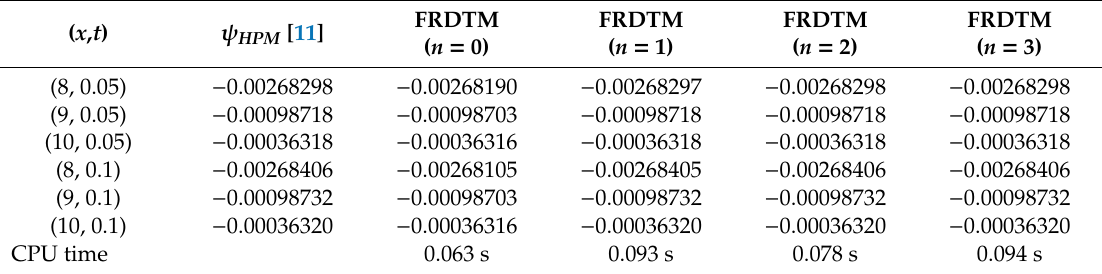
Table 3. The two term FRDTM approximation results of mCH equation with HPM [11] for α = 1